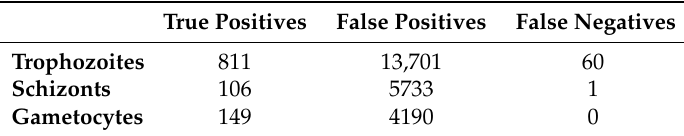
Table 4. Results after the segmentation step for each MP